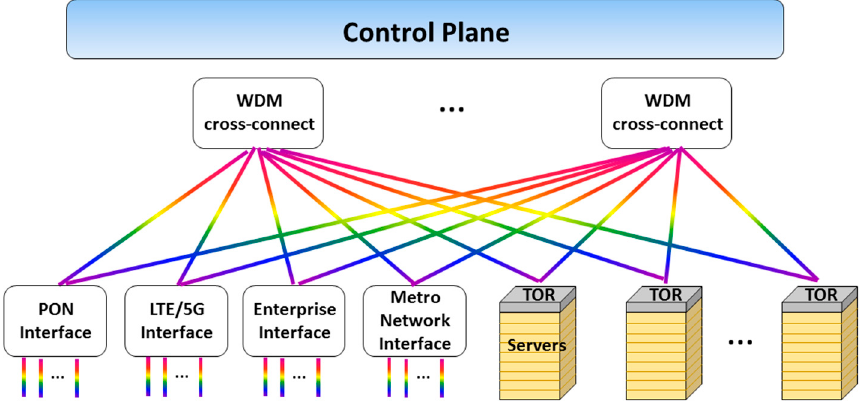
Figure 2. Optical metro node architecture exploiting the Wavelength Division Multiplexing (WDM)